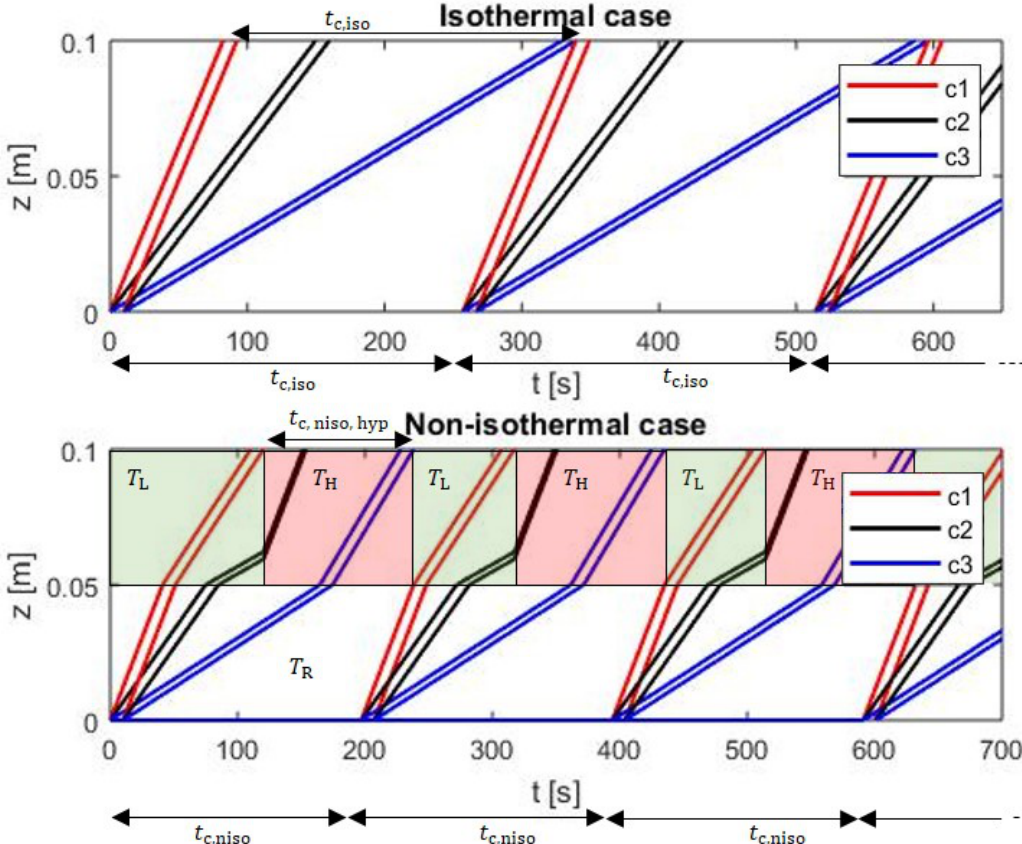
Figure 7. The space-time trajectories for three components under isothermal (3 injections) and the non-isothermal (4 injections) conditions. In the non-isothermal case, the first switching of the temperature is done at t 1,max and second switching at t 3,max and then they shift by t c,niso